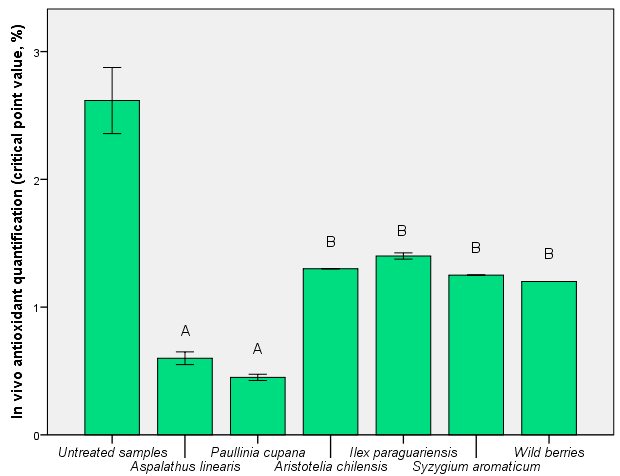
Figure 5. In vivo antioxidant activity before the bioassimilation process, but in the presence of extracts. Different letters represent significant statistical differences (untreated sample vs. samples; p ≤ 0.05), n = 3; untreated sample was used as control.